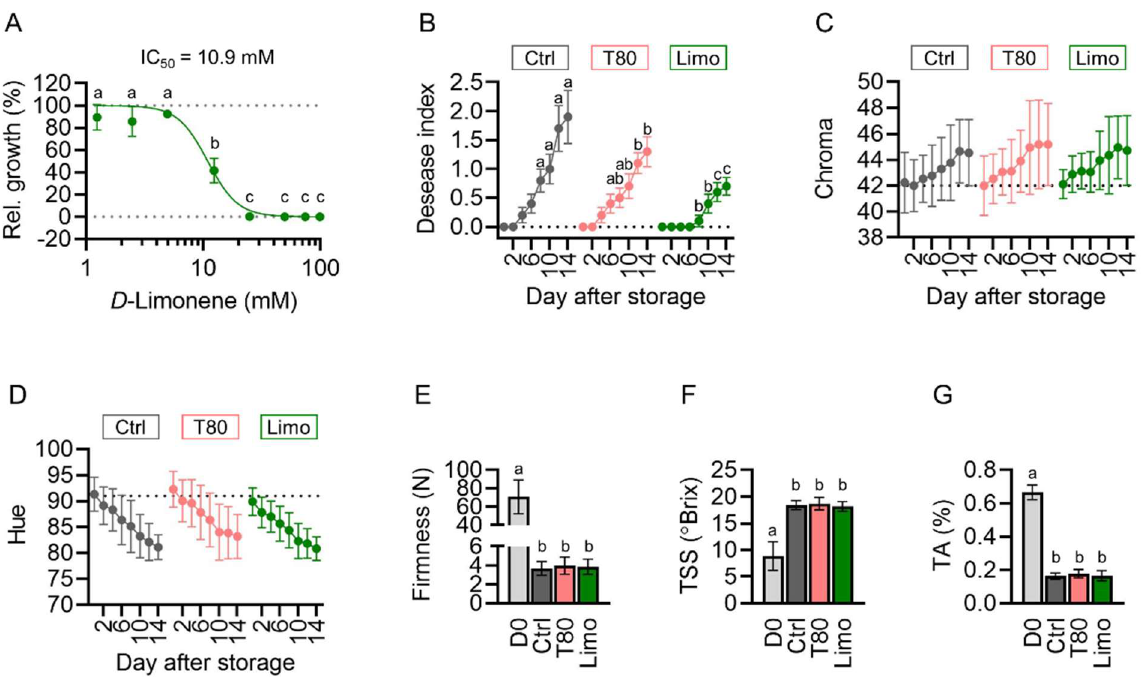
Figure 6. D -limonene inhibits Colletotrichum gloeosporioides in vitro and in vivo. ( A ) The inhibition curve and IC 50 of d -limonene against C. gloeosporioides determined by in vitro assay. ( B ) The disease index of fruit treated with water, Tween ® 80 (T80), or 6.2 mM d -limonene (Limo). ( C – G ) The fruit physiology. The chroma ( C ) and hue ( D ) of the fruit surface determined by a CR-400 chromameter. The firmness ( E ) of fruit determined by a TA.XTplus Texture Analyser. The total soluble solids ( F ) and titratable acids ( G ) determined by a PAL-1 digital refractometer and a Titrando automated titration system, respectively. Data are presented as mean ± SD ( A , C – G ) or SEM ( B ). Significant differences are indicated by different alphabets (Tukey’s tests, p < 0.05; ( A ): n = 5; ( B – G ): n =